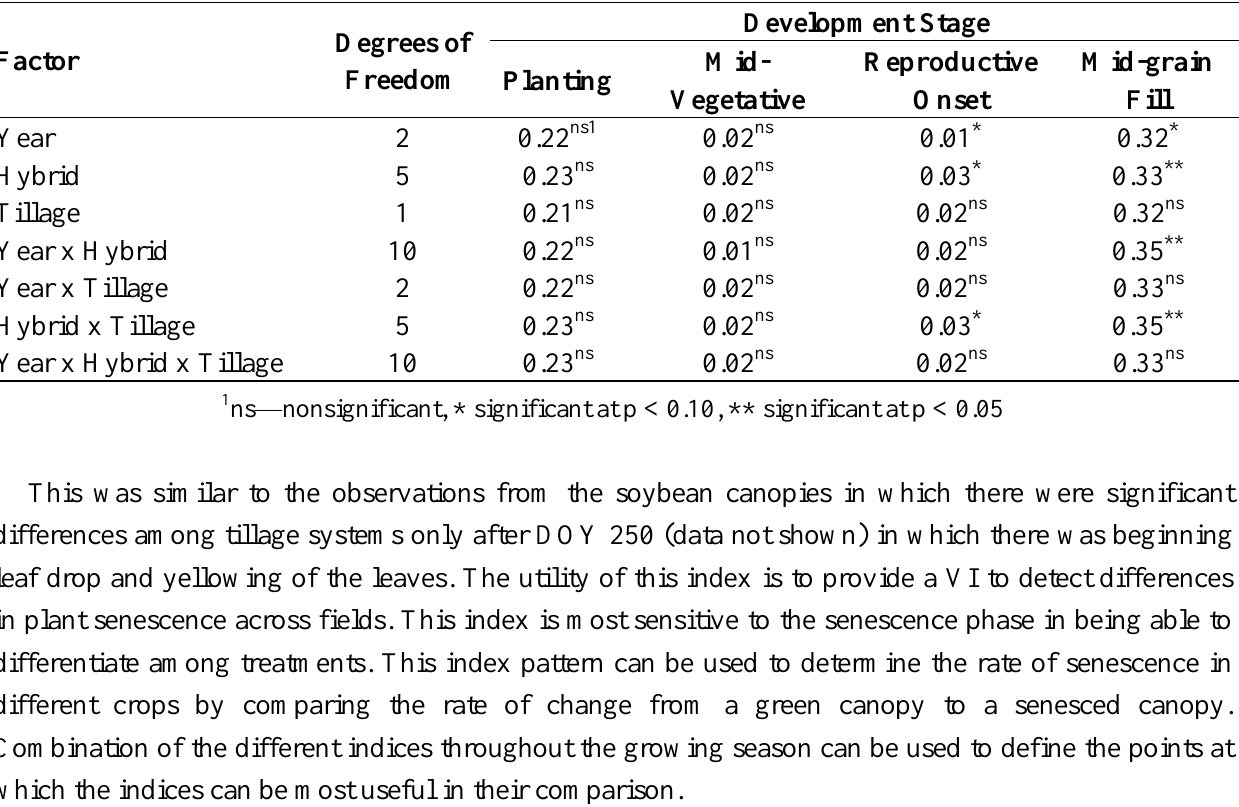
Table 5. Mean values of PSRI observations over six corn hybrids grown in two tillage systems for the period from 2002–2004 for four development periods and the ANOVA for the comparison of the treatments and